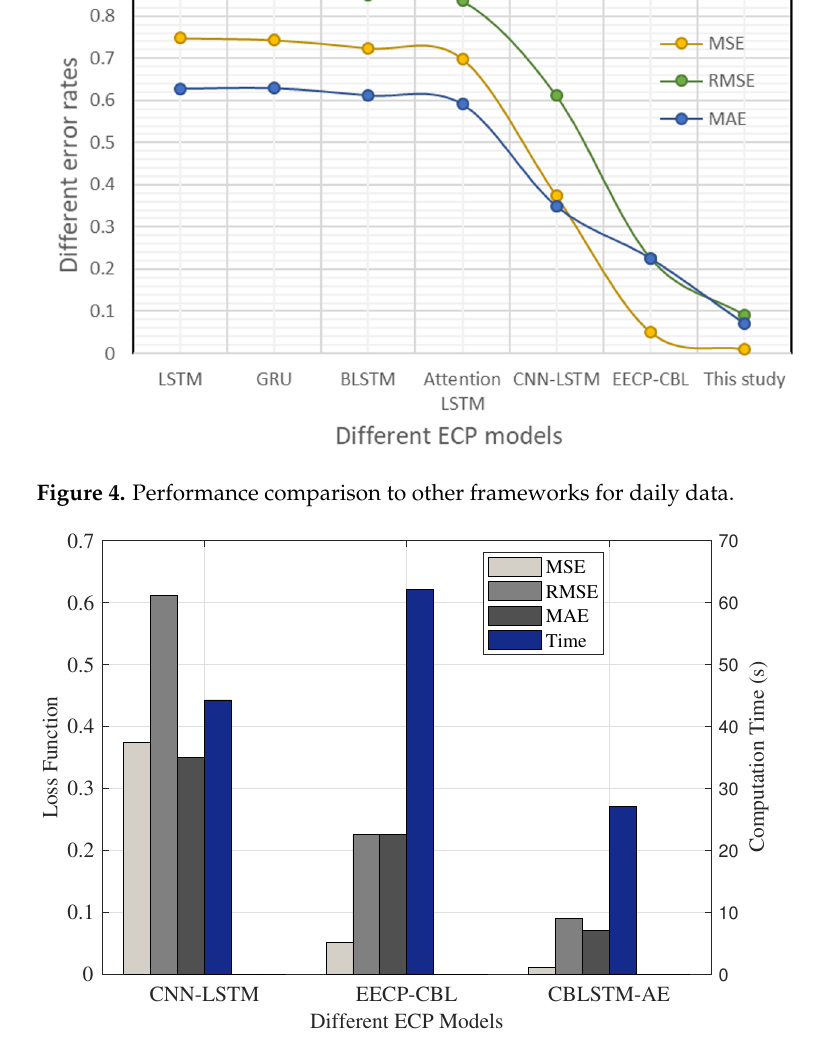
Figure 5. Performance comparison to other frameworks with computation